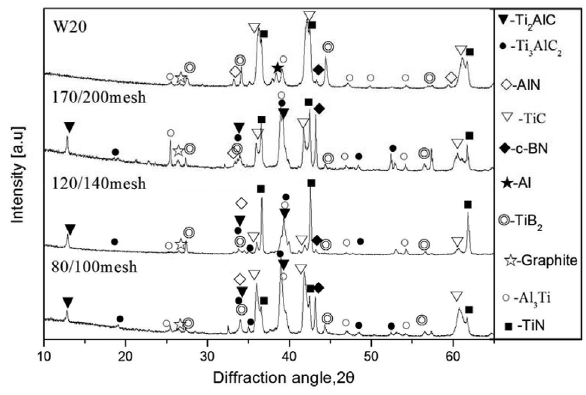
Figure 5: The XRD patterns of the samples that contained different c- BN (10%) particle sizes obtained by SHS.